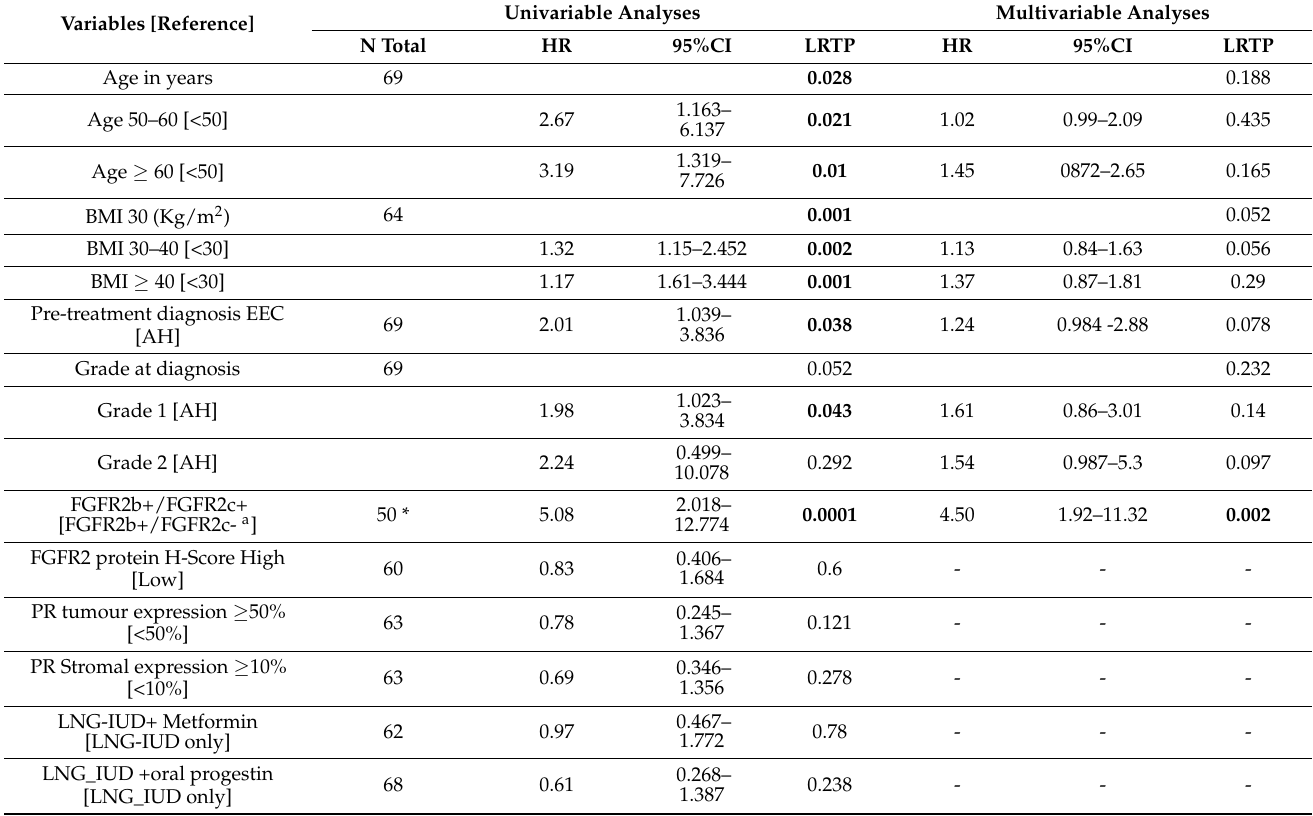
Table 2. Univariable and Multivariable Cox regression proportional hazard model